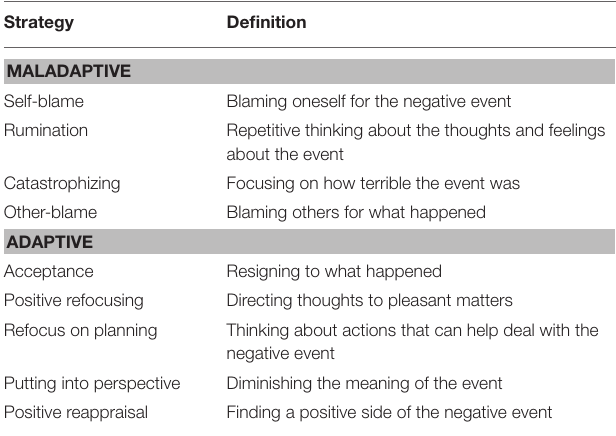
TABLE 1 | Definitions of the adaptive and maladaptive Cognitive Emotion Regulation Strategies (Garnefski et al.,